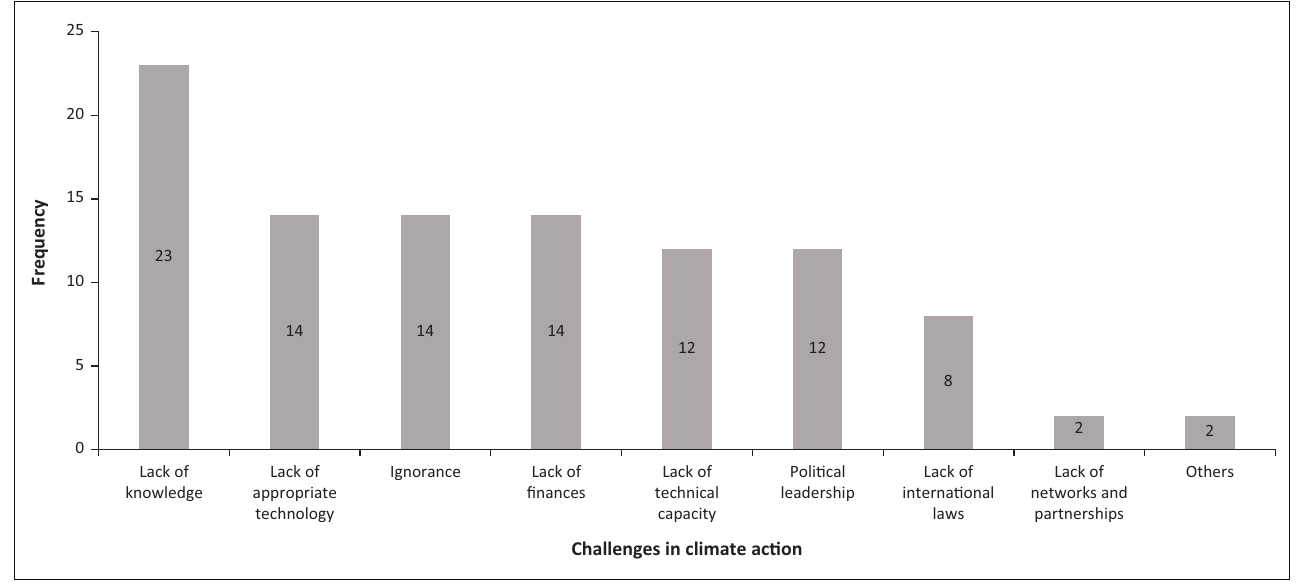
FIGURE 4: Challenges faced by tourism role players in dealing with climate change ( n =